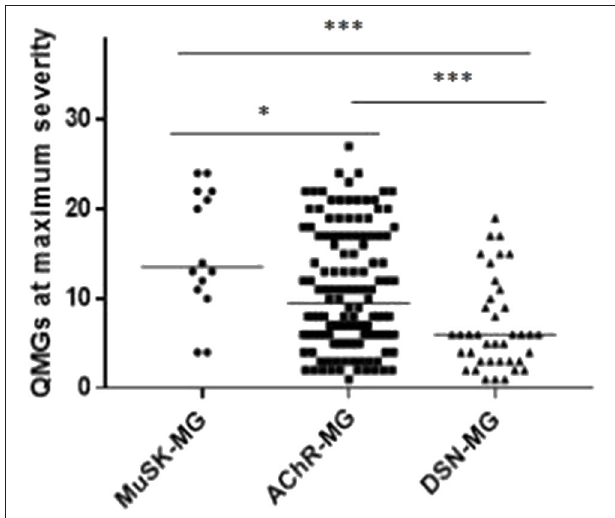
FIGURE 2 | Comparison of maximum QMGs in each group. The maximum QMGs in MuSK-MG group was more severe than that in AChR-MG group and DSN-MG group. Moreover, QMGs in AChR-MG group was significantly higher than that in DSN-MG group. Comparison between groups was done by Mann-Whitney test. * indicates P < 0.05, *** indicates P < 0.001.